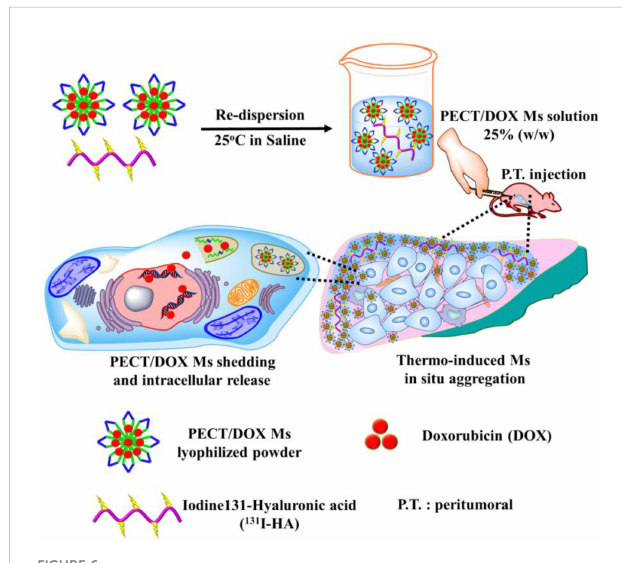
FIGURE 6 The schematic diagram of the formation of PECT/DOX MHg as the nanodrug and radionuclide reservoir and its following action model of in situ chemoradiotherapy (82).